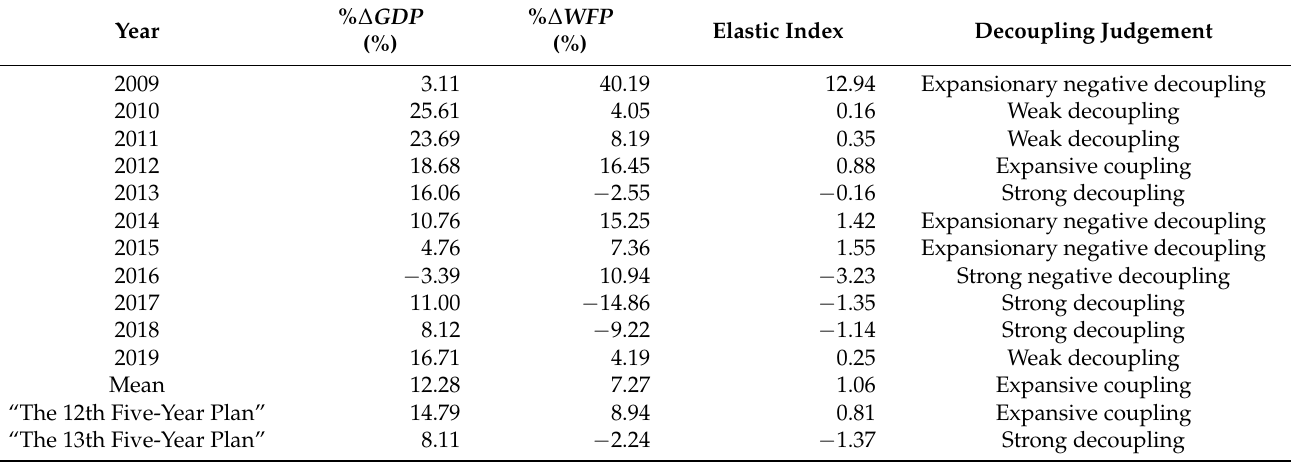
Figure 8. 2008–2019 Coordination relationship between economic growth and water resources uti- lization in Tarim River Basin. Data source: According to the statistical yearbook of Xinjiang.